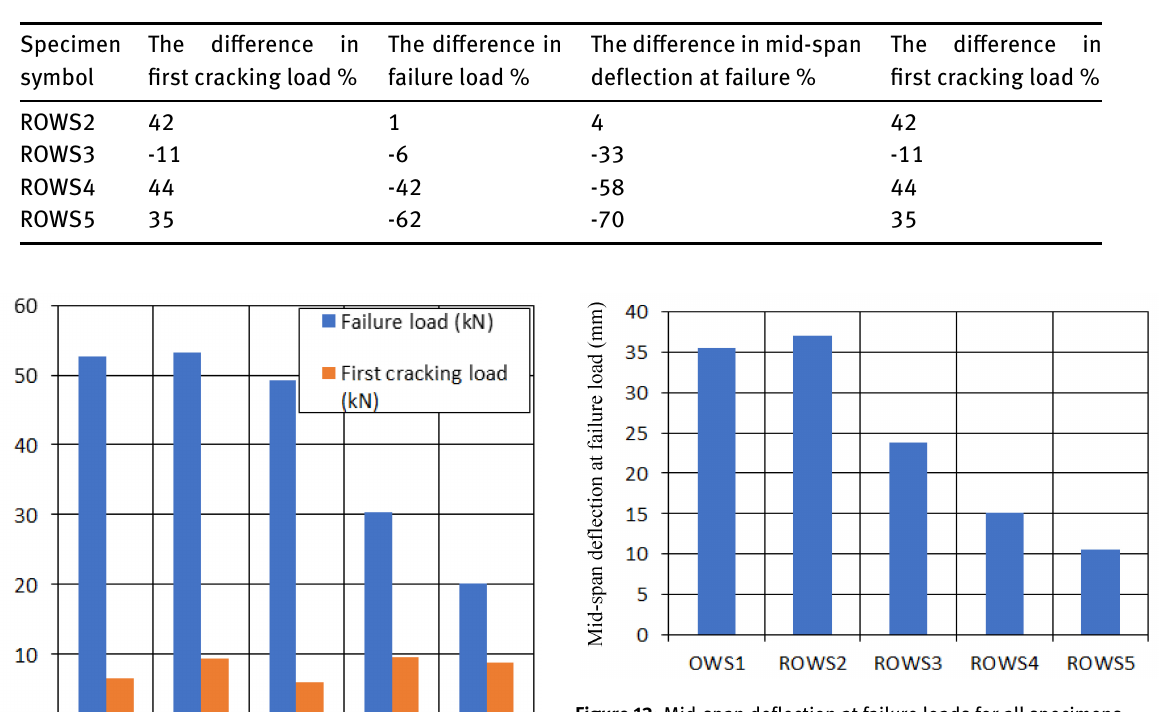
Table 2: Difference in first cracking load, failure load, and mid-span deflection at failure load of specimens concerning with control speci- men (OWS1).